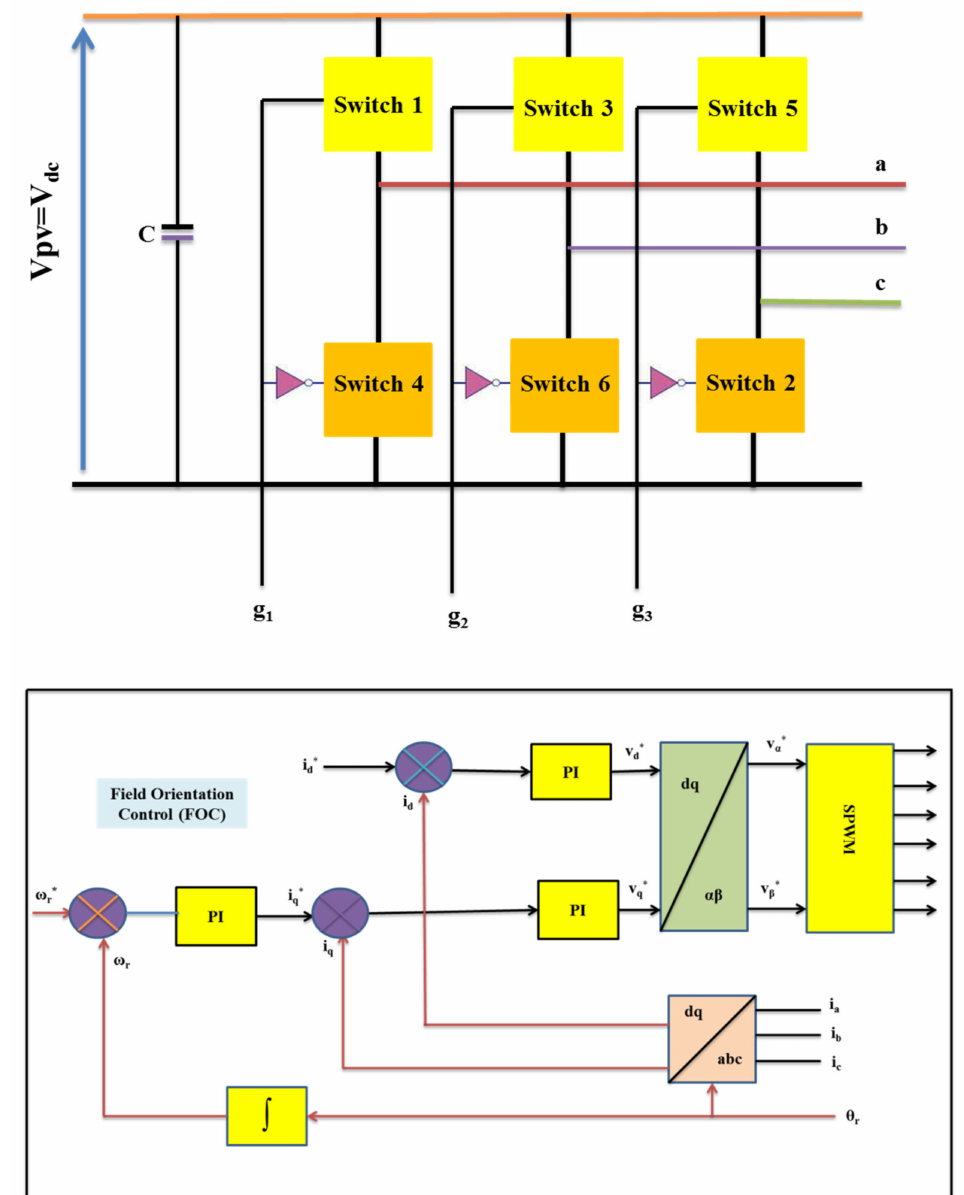
Figure 7. The three-phase voltage source inverter equivalent circuit diagram ( top ). The field orienta- tion control strategy schematic diagram ( bottom